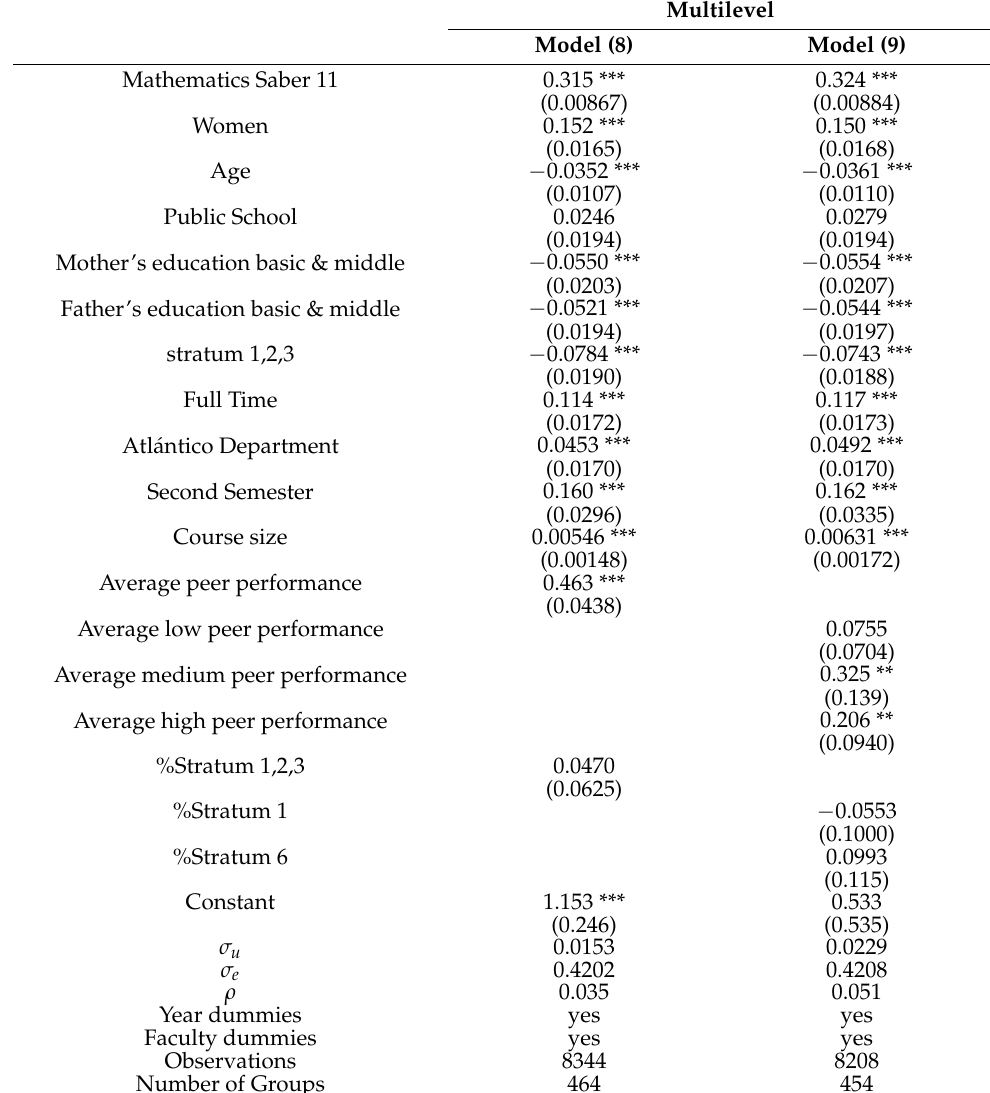
Table 5. Peer effects on academic performance in Calculus I—Multilevel.